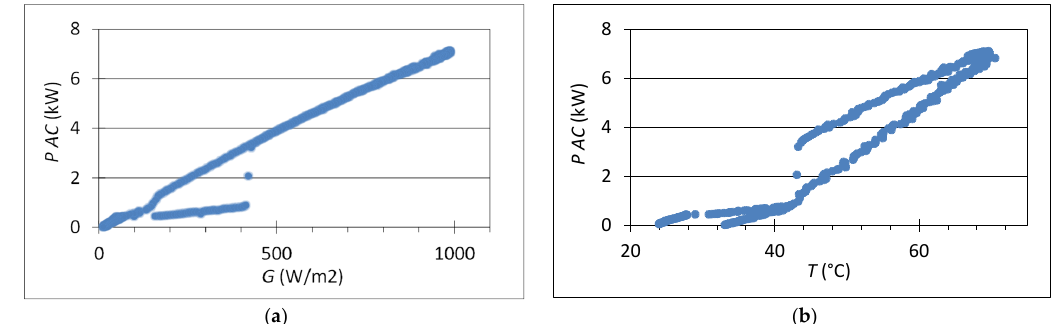
Figure 7. The variation of inverter output power in regard to ambient conditions: ( a ) dependency of irradiation; ( b ) dependency on the temperature.